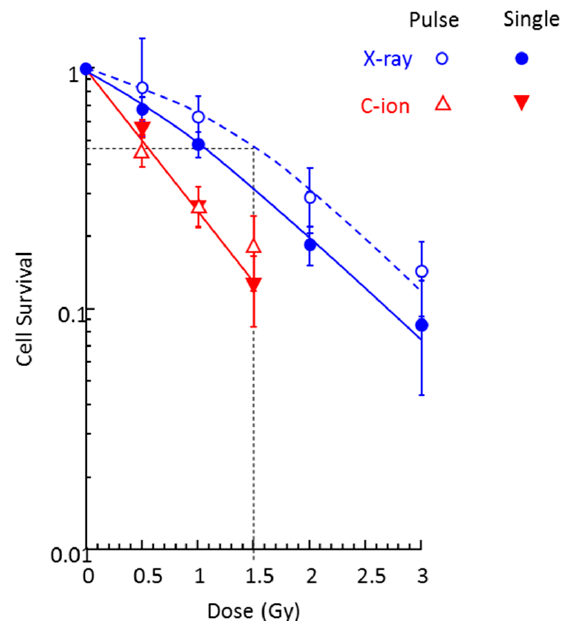
Figure 1. Survival curves of human fibroblasts irradiated by a single dose (open symbols) or the same cumulative dose given by 0.2 s pulses (closed symbols) of X-ray and 290 MeV/n C-ion beam under static conditions. Experimental data represent the mean of two plates from four experiments.